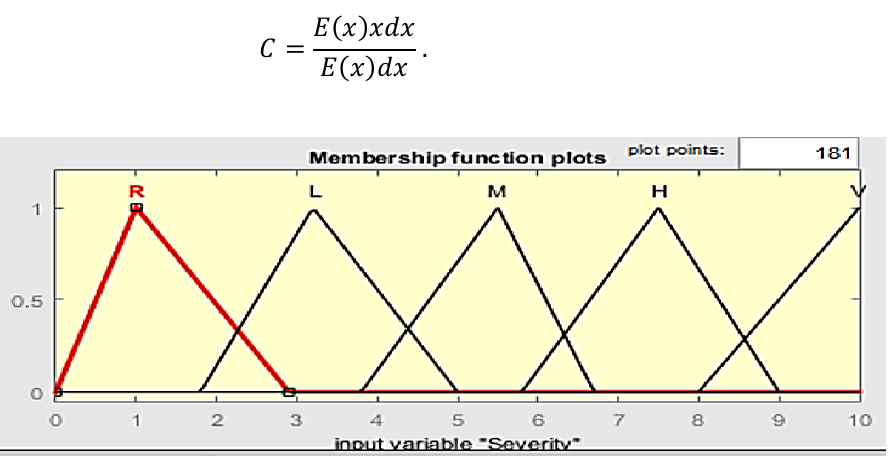
Figure 2. Membership Function for Severity (Matlab).